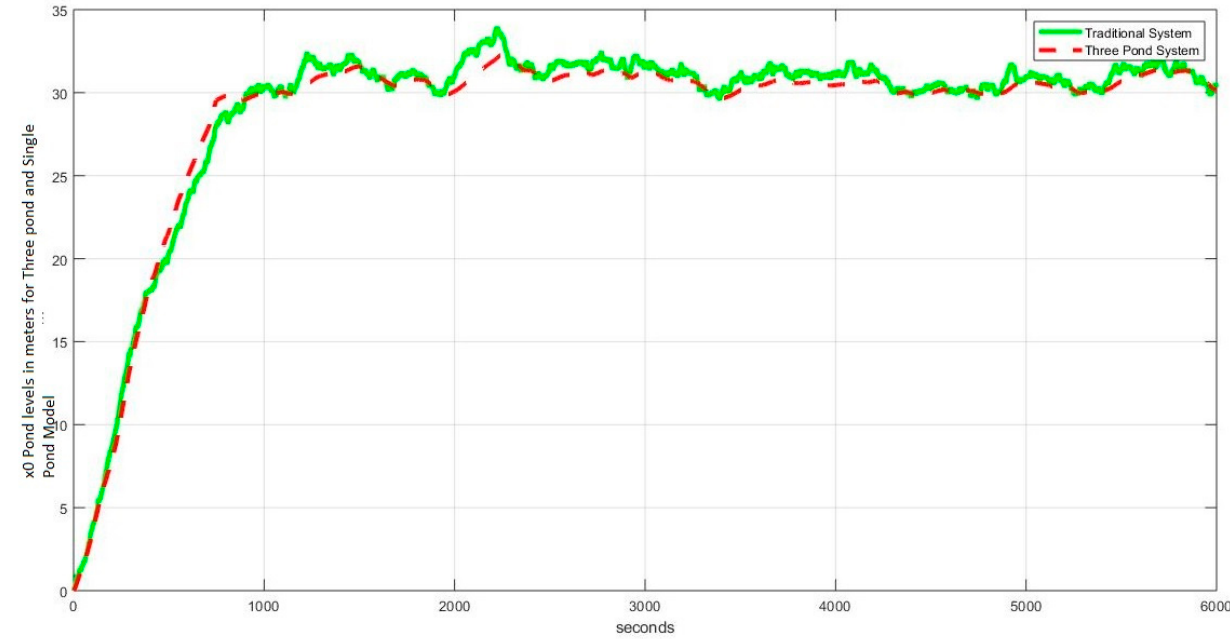
Figure 23. Comparison between the proposed system (half) and traditional system (white noise disturbance).